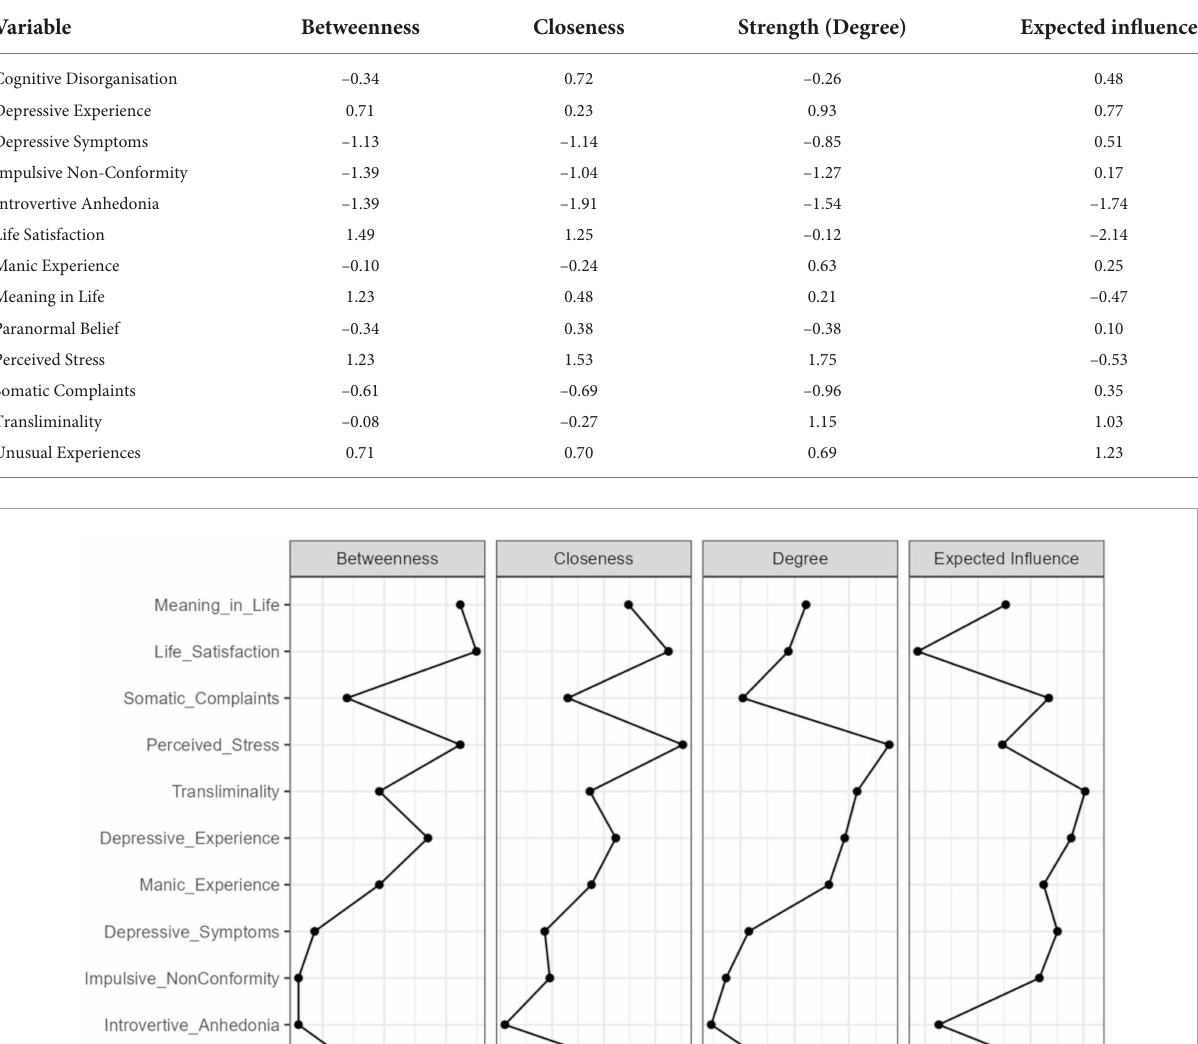
TABLE 2 Centrality measures.